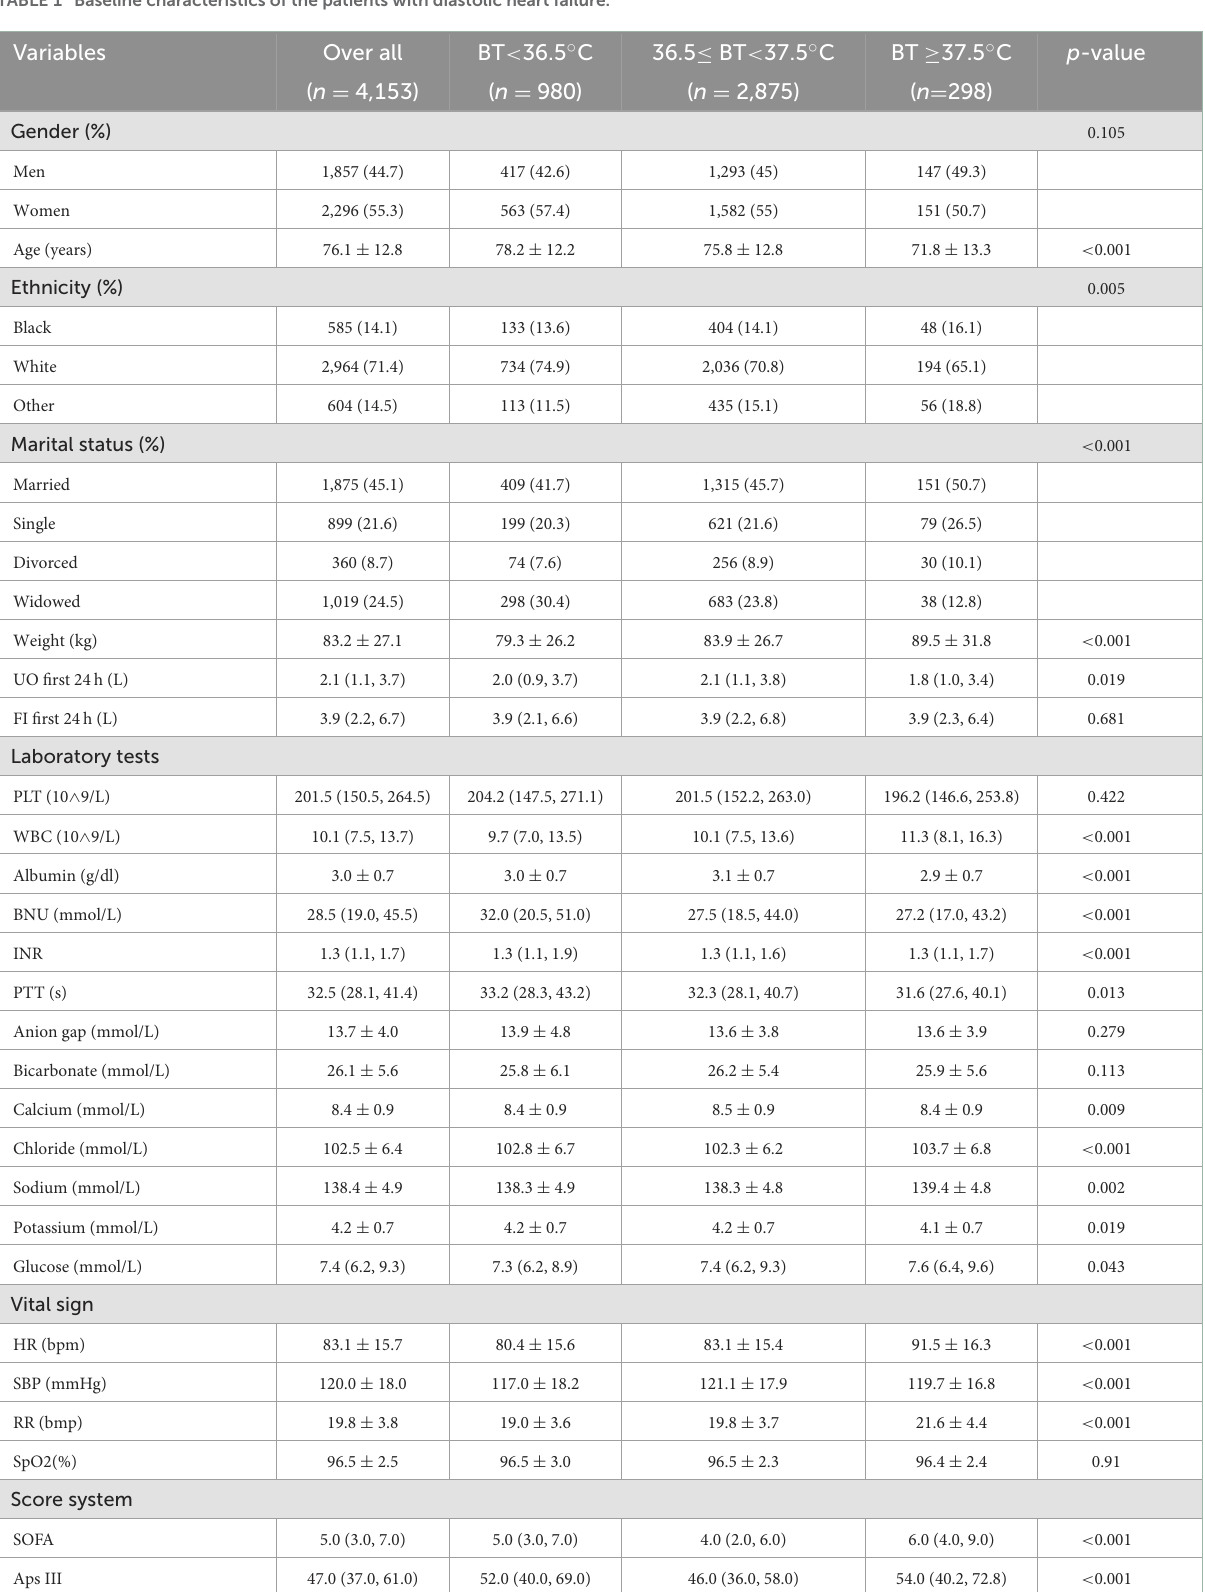
TABLE 1 Baseline characteristics of the patients with diastolic heart